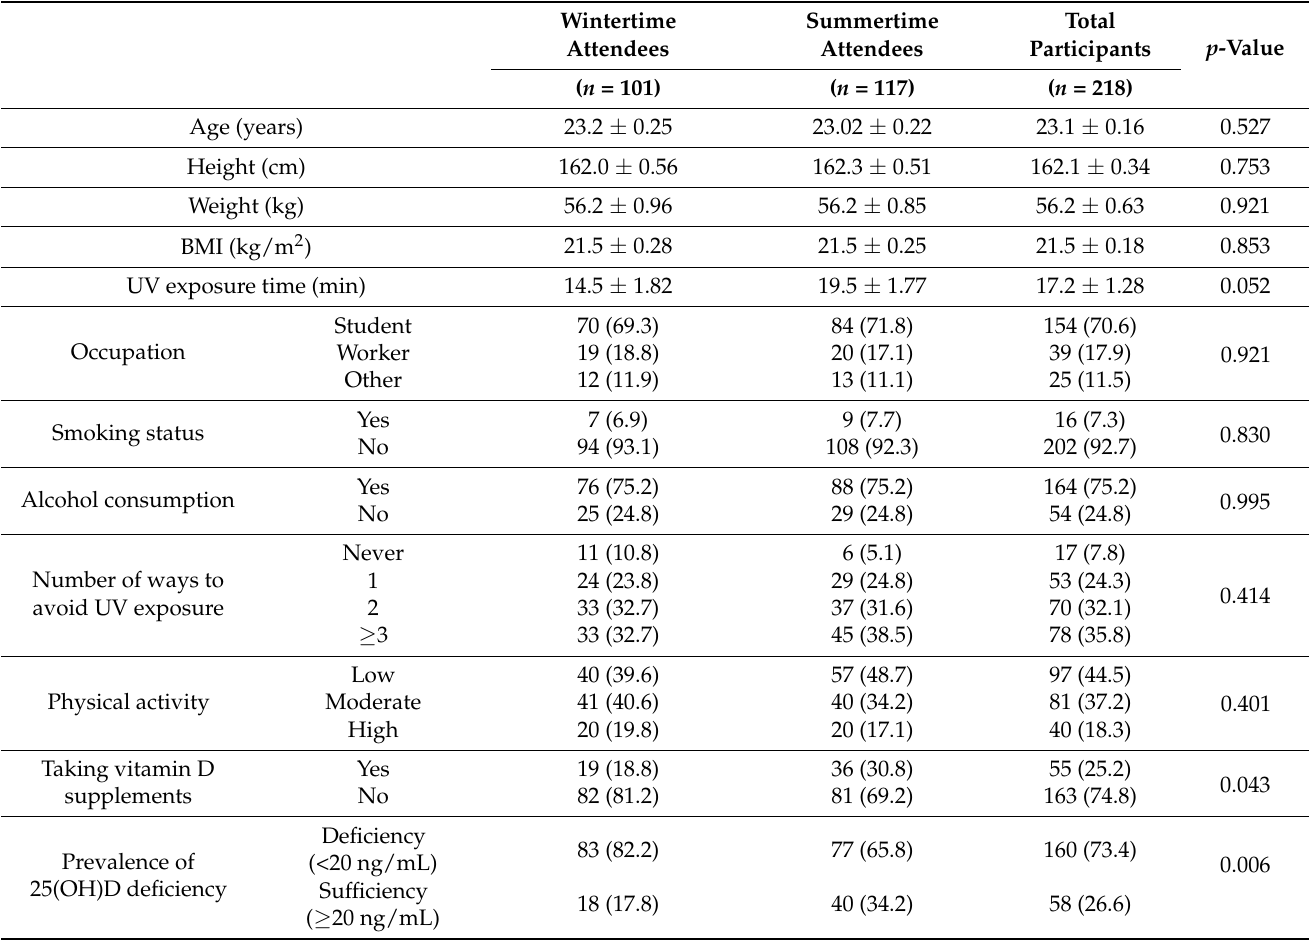
Table 1. General and lifestyle characteristics of the